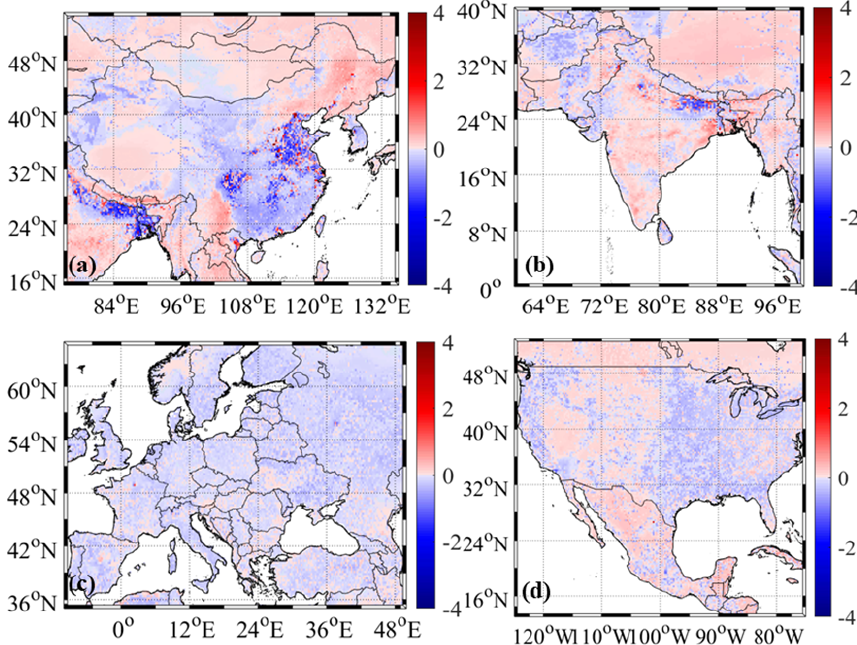
Figure 4. The concentration difference for deweathered benzene between the COVID-19 period in 2020 and the same period in 2019 in (a) East Asia, (b) South Asia, (c) Europe, and (d) North America (difference = deweathered benzene concentration in 2020 − deweathered benzene concentration in 2019) (unit: µgm − 3 ).